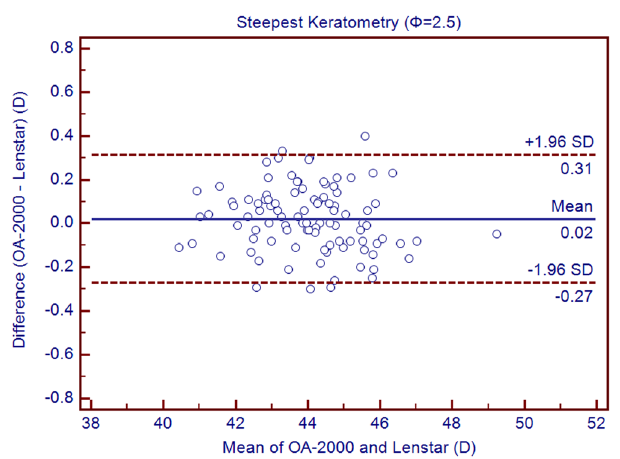
Figure 8. Bland-Altman plots show the agreement between OA-2000 swept-source optical coherence tomography and Lenstar optical low coherence reflectometry for measuring steep keratometry (Ks) at 2.5 mm. Solid lines represent the bias between both devices and dotted lines represent the 95% confidence interval for the